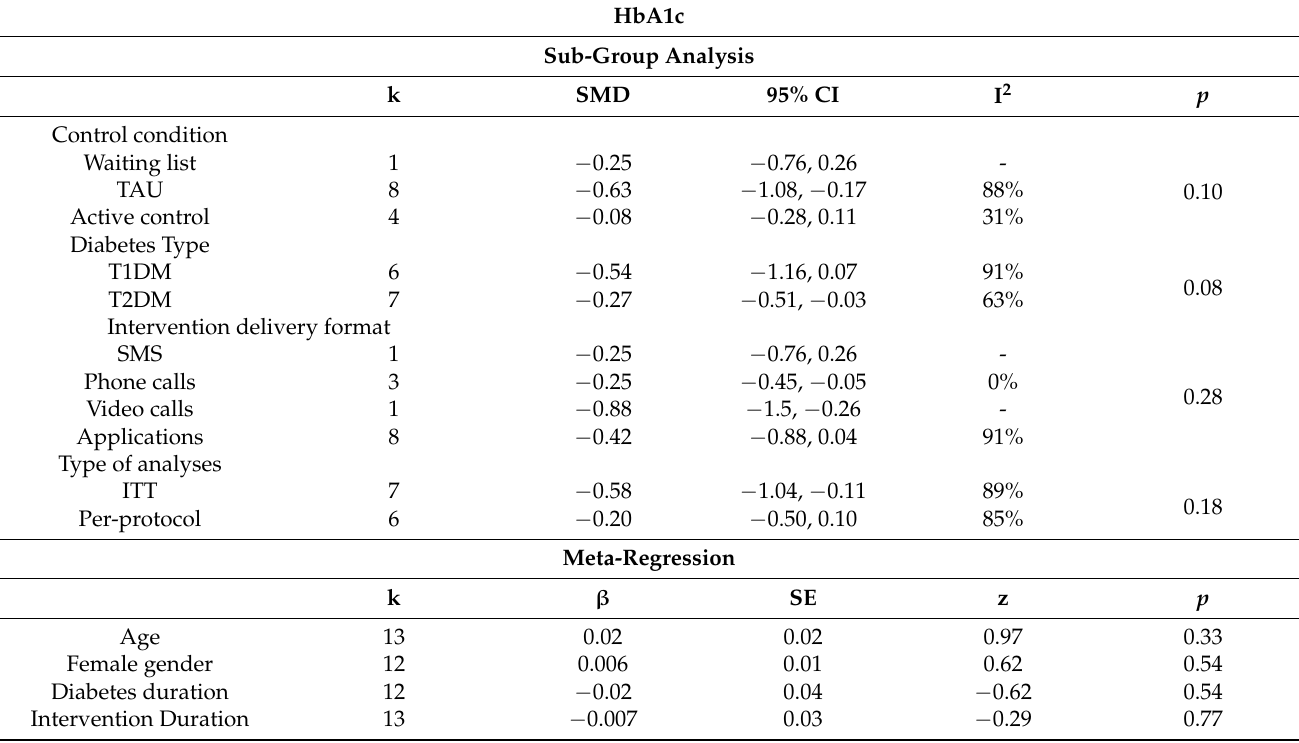
Table 3. Sub-group and meta-regression